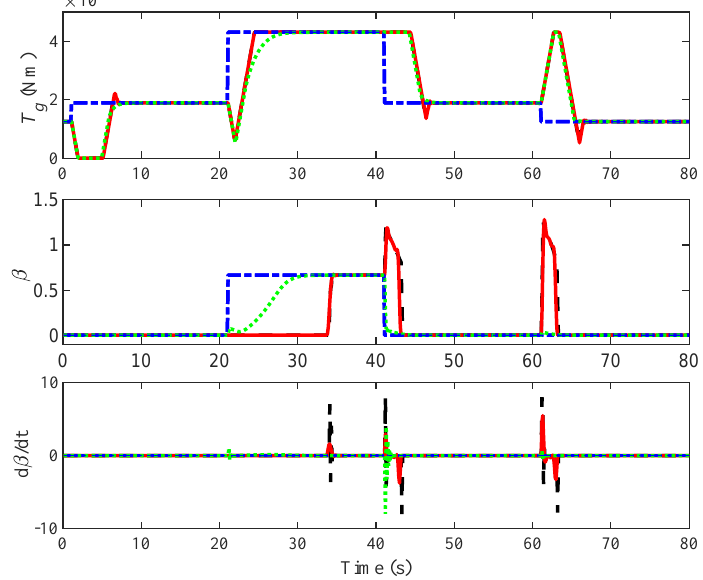
Figure 8. States T g , β and d β / dt for the proposed EMPC 1 (black dash-dotted line), EMPC 2 (red solid line) and classical tracking MPC (green dashed line) under gradient